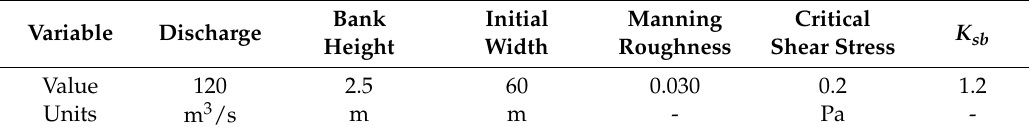
Table 3. Numerical values used for large scale case (Motta et al.’s case).